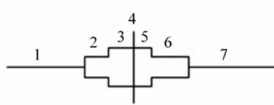
Figure 1. Graphical representation of the dynamics in the achievement of the annual pollen sum. Stages of the pollen season: (1) 1–5%, (2) 5–25%, (3) 25–50%, (4) 50%, (5) 50–75%, (6) 75–95%, and (7)